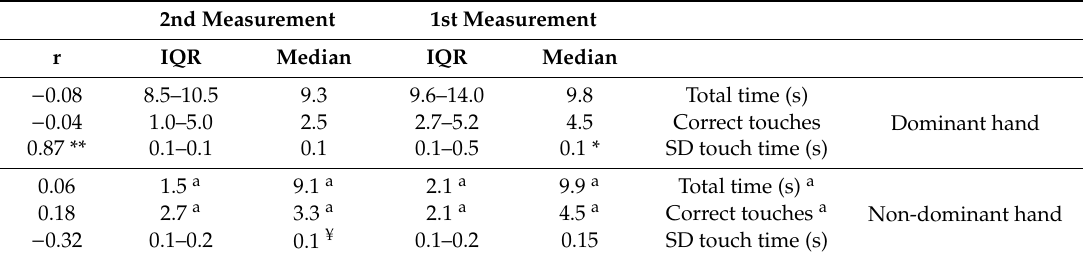
Table 4. Median and interquartile range (IQR) of the Computerized Thumb-Finger Test scores and the Spearman correlations between the two measurement times (test-retest) ( n =